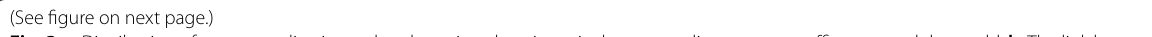
agriculture(See figure on next Fig. 3 a Distribution of patent applications related to microalgae in agriculture according to patent offices around the world. b. The link between resident and non-resident patents related to microalgae in